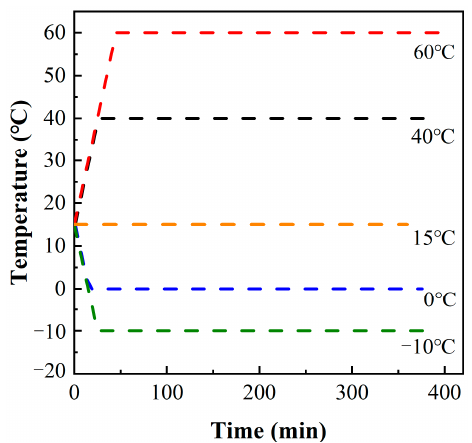
Figure 9. Temperature change curve of the furnace at the thermostat.